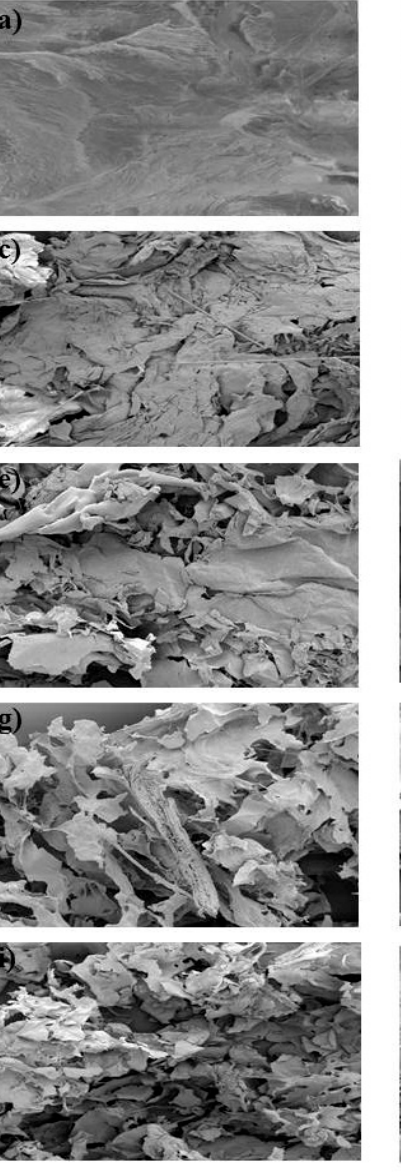
Figure 3. Scanning Electron Microscopy (SEM) of apricot pomace by 70× ( a,c,e,g,i ) and by 575× ( b,d,f,h,j ); ( a, b ), untreated, ( c, d ) solid-liquid, ( e, f ) ultrasound, ( g, h ) microwave, and ( i, j ) infrared.